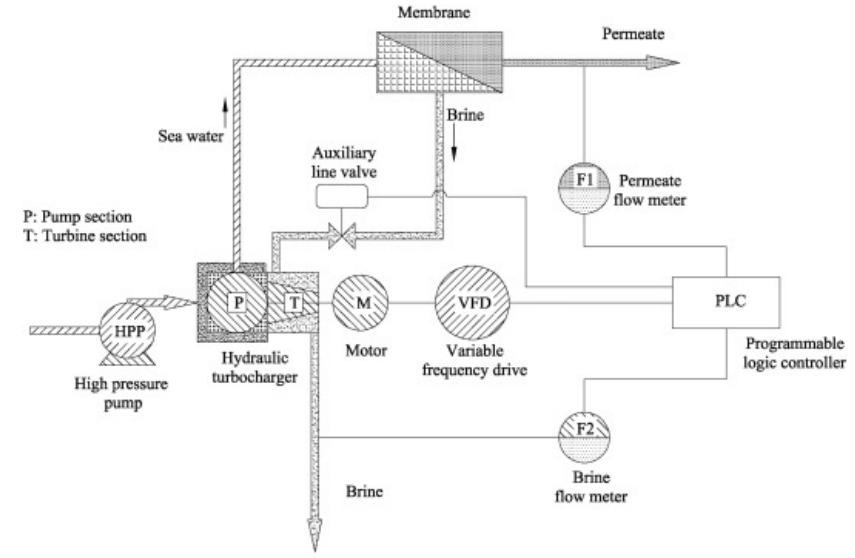
Figure 17. The control scheme of the HEMI system [30].